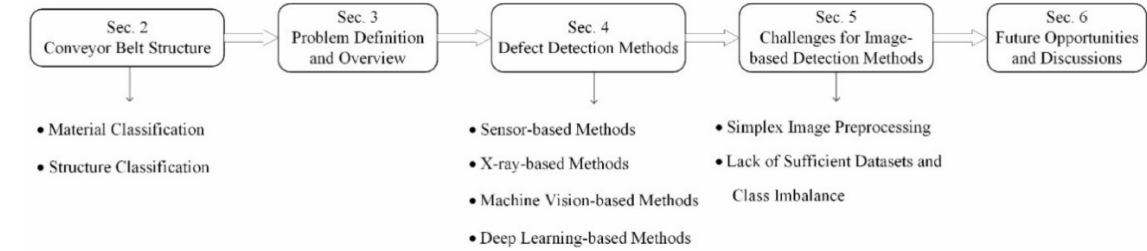
Figure 1. Overview of defect detection for conveyor